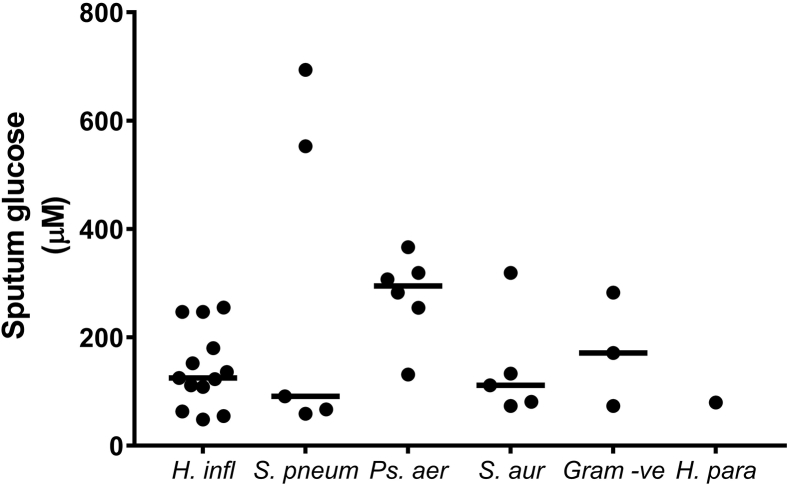
Sputum glucose concentrations and bacterial species. Gram–ve, Gram negative; H. infl, Haemophilus influenzae; H. para, Haemophilus parainfluenzae; Ps. aer, Pseudomonas aeruginosa; S. aur, Staphylococcus aureus; S. pneum, Streptococcus pneumoniae.